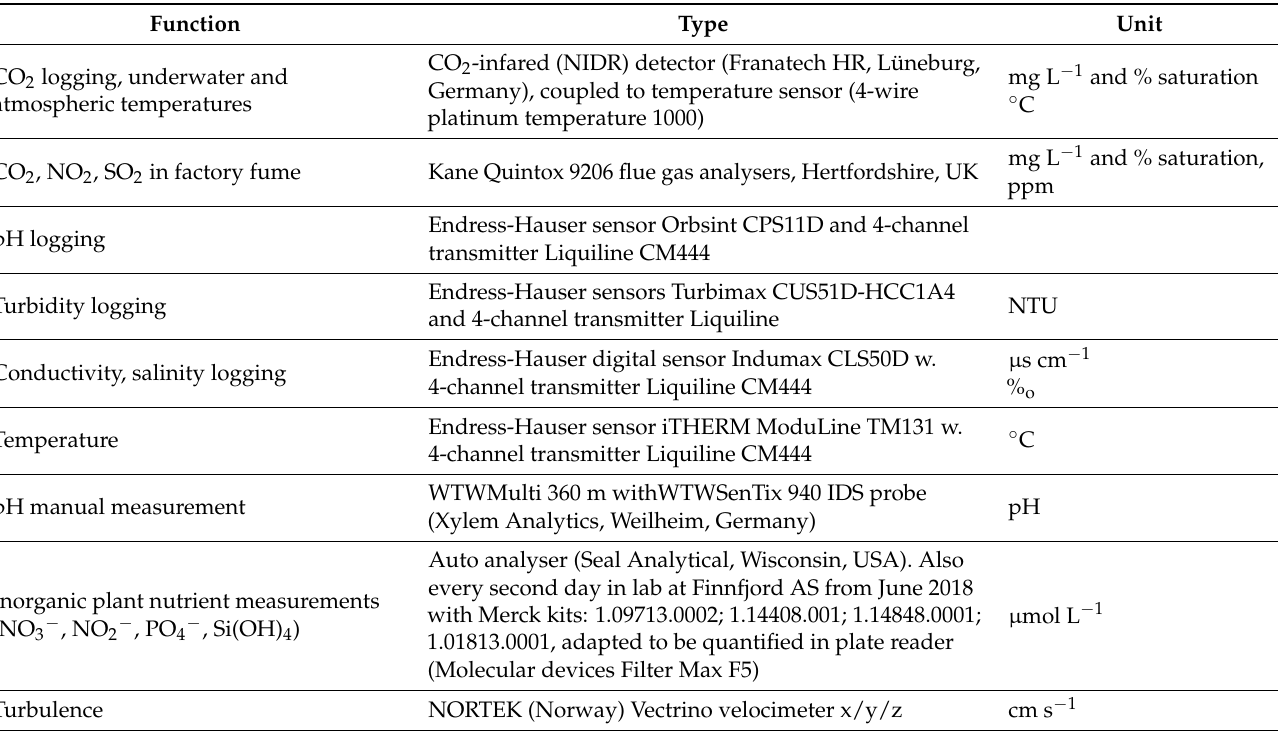
Table 2. Inventory of main functions in the microalgae (diatom) mass cultivation